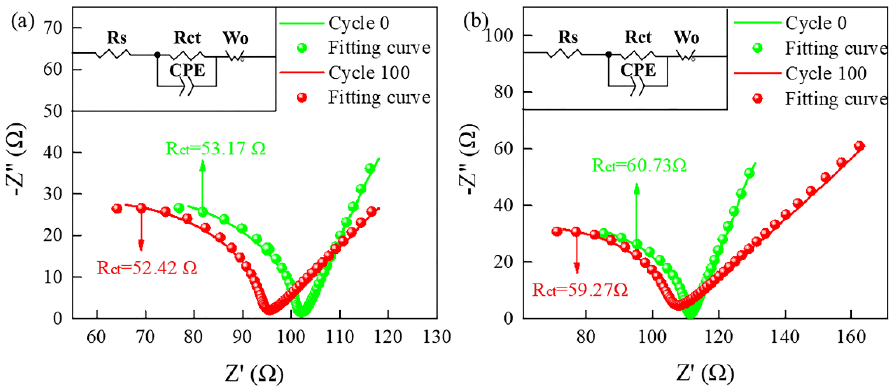
Figure 8. EIS diagram of films N − 400 ( a ) and N − 450 ( b ).